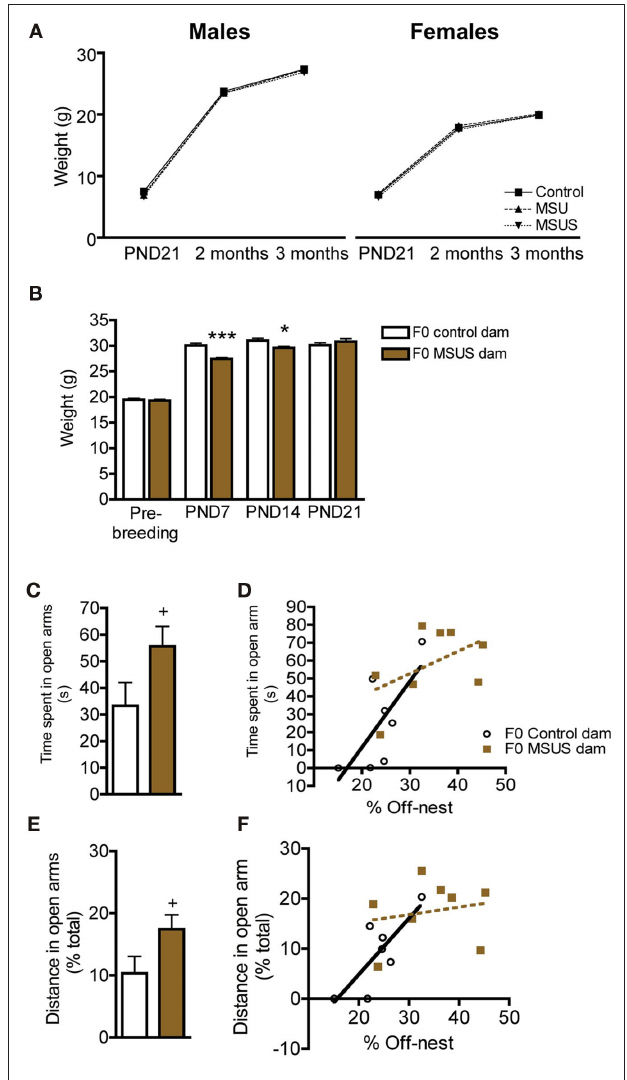
Figure 1 | Body weight in F 1 control, MSu and MSuS, and body weight and behaviors in F 0 control and MSuS dams. (A) F 1 MSU males ( n = 21) and F 1 MSUS males ( n = 23), and F 1 MSU females ( n = 20) and F 1 MSUS females ( n = 26) had normal body weight despite early stress treatment compared to F 1 control males ( n = 25) and F 1 control females ( n = 20), respectively. (B) Reduced body weight in F 0 MSUS dams ( n = 11) during the period of separation (PND7 and PND14), but no significant difference 1 week after the end of separation (PND21; not measured in MSU females), compared to F 0 control dams ( n = 12). (C) Increased time spent in the open arms in F 0 MSUS dams ( n = 8) compared to F 0 control dams ( n = 8). (D) Significant correlation between time spent in open arms and time spent off-nest in F 0 control dams, but not in F 0 MSUS dams. (e) Increased proportion of total distance covered in the open arms in F 0 MSUS dams ( n = 8) compared to F 0 control dams ( n = 8). (F) Significant correlation between distance in open arms and time spent off-nest in F 0 control dams, but not F 0 MSUS dams. 0.05 < + < 0.1; * p < 0.05; *** p < 0.001. Bar graphs represent mean values ±